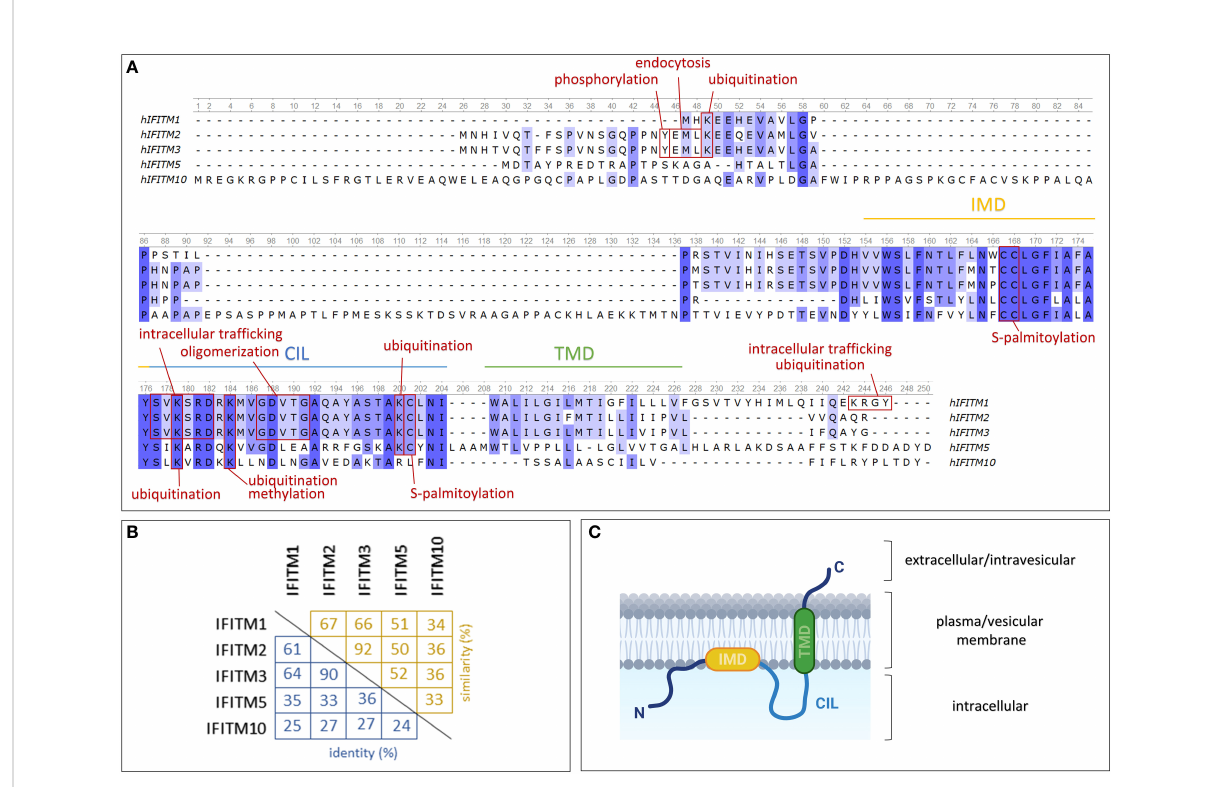
FIGURE 1 Structures of IFITM protein family members expressed in humans. (A) Comparison of protein sequences using a multiple alignment tool (Unipro UGENE) with relevant protein domains and sites of posttranslational modi fi cations indicated. (B) Percentage of mutual IFITM protein identity (blue) and similarity (yellow). (C) One of the proposed models of IFITM protein topology in the plasma/vesicular membrane. IMD – intramembrane domain (amphipathic helix); CIL – conserved intracellular loop; TMD – transmembrane domain. Created with